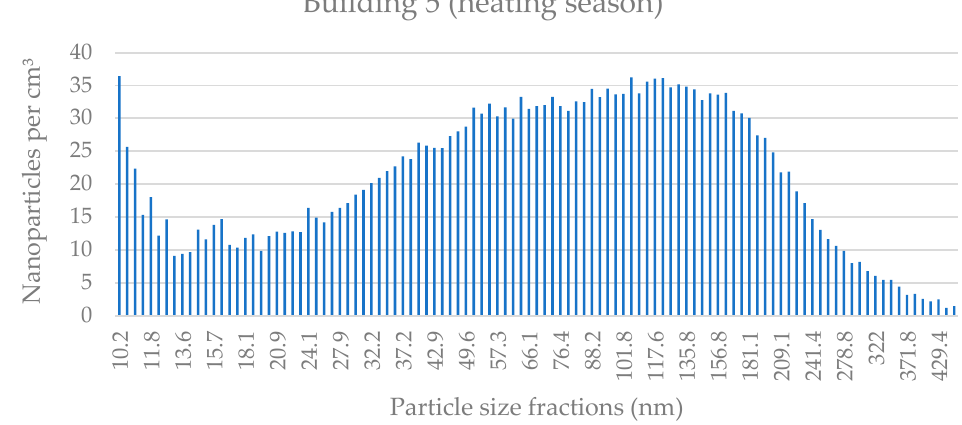
Figure A9. The average nanoparticle concentration in each size fraction in Building 5 during a one-week measurement period during the heating season.